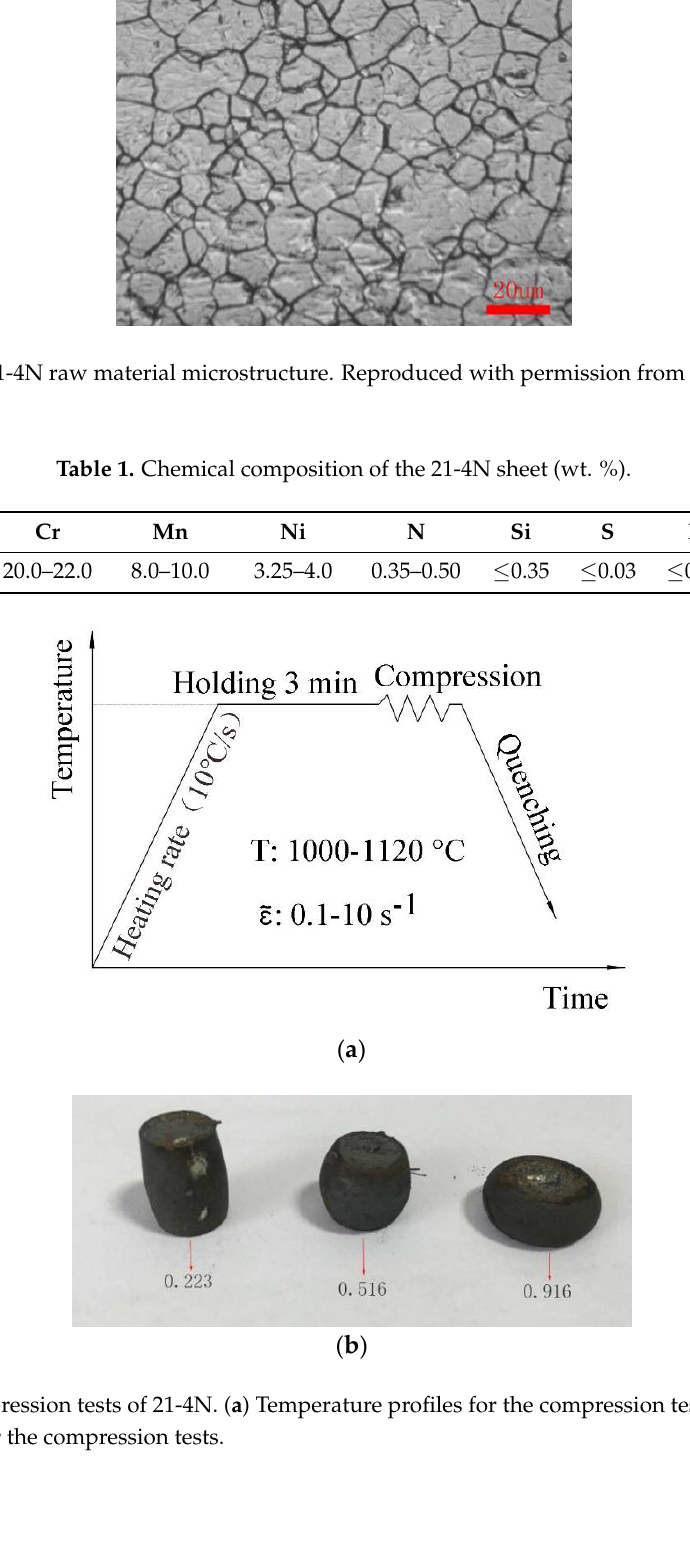
Table 1. Chemical composition of the 21-4N sheet (wt. %).